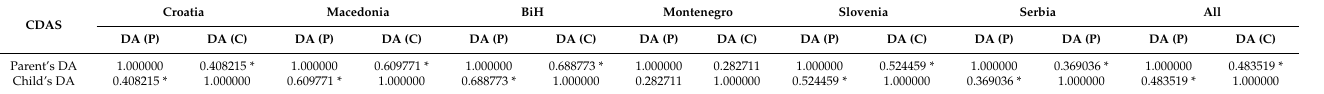
Table 4. Correlation between dental anxiety of parents and children attending primary school and high school under 18 years of age; Spearman rank correlation (marked correlations are significant at p < 0.01); included: primary and secondary school; excluded: polytechnic school and